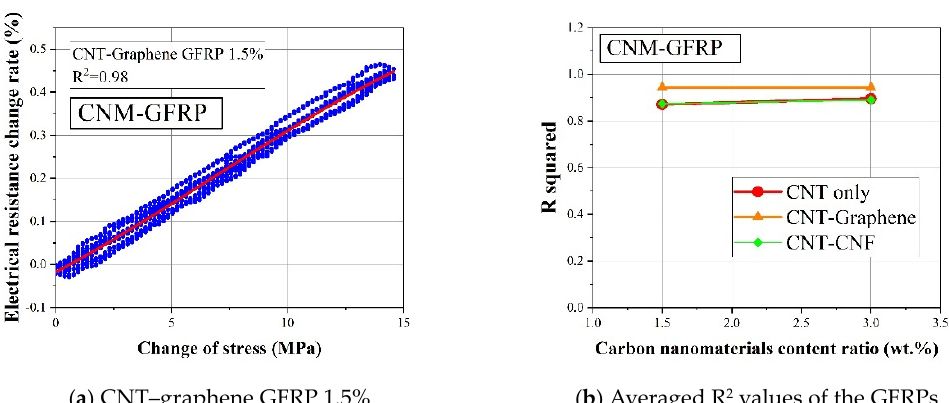
Figure 12. ( a ) Cubic polynomial regression fitted from the applied loading and electrical resistance change rates and ( b ) averaged R 2 values of the CNM-incorporated GFRP